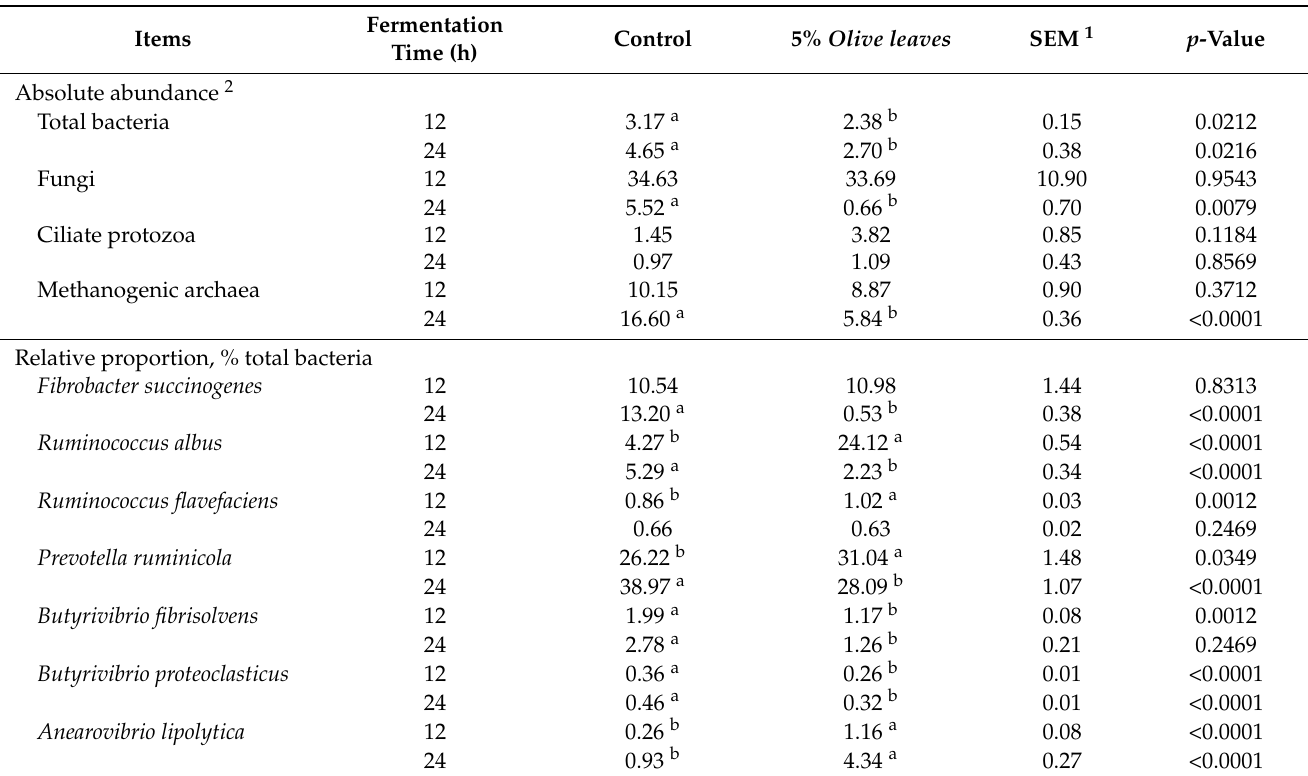
Table 7. Effect of 5% olive leaves (OLs) on the relative quantification of rumen microorganism populations under in vitro ruminal fermentation for 12 and 24